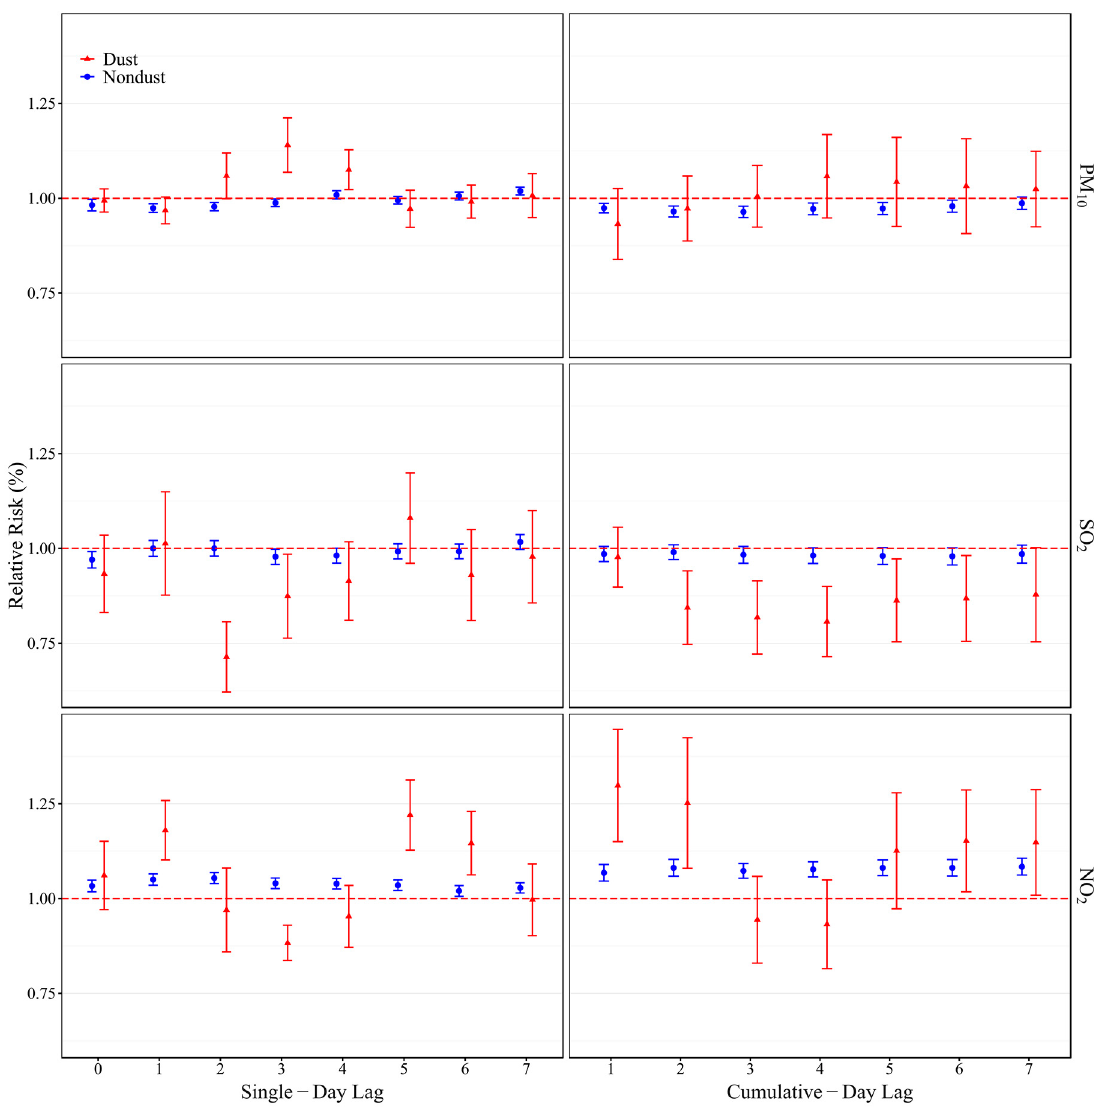
Figure 1. RRs (95%CIs) of ER visits with an increase of 10 µ g/m 3 in air pollutants at single-day lags ( left ) and cumulative-day lags ( right ) in spring in Lanzhou,